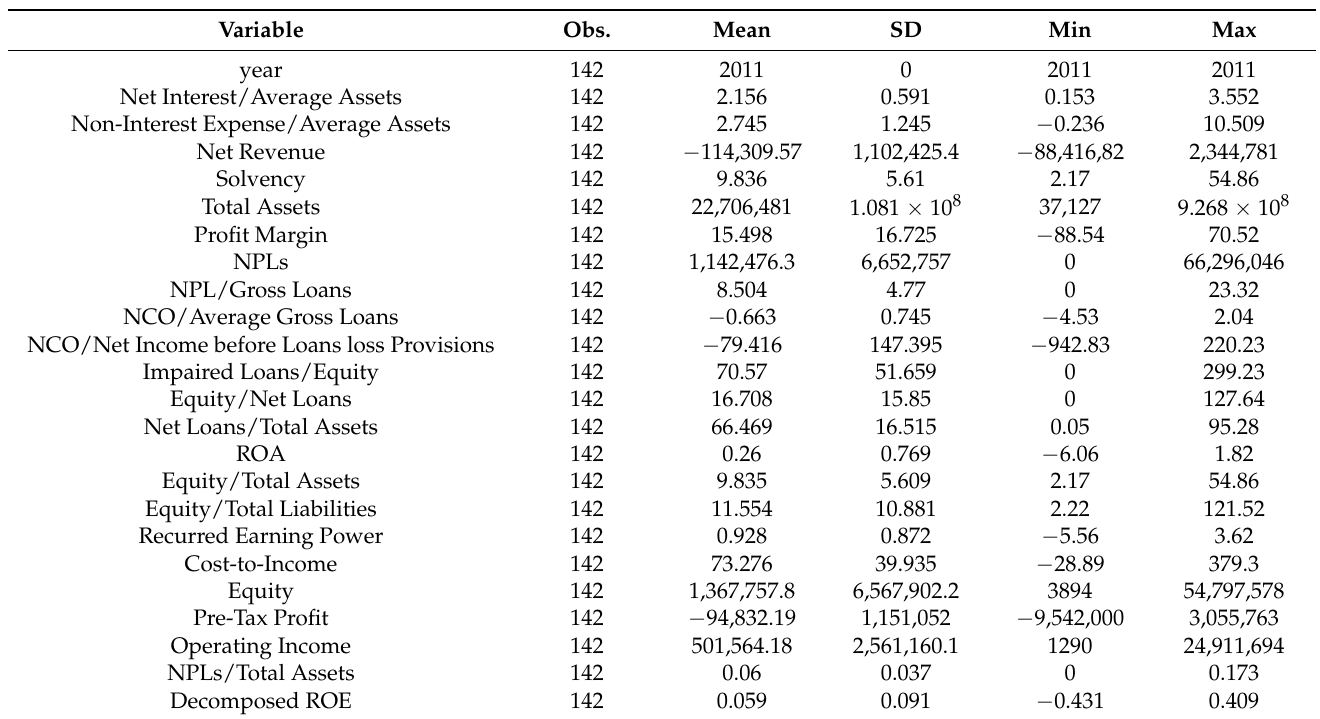
Table A1. Descriptive statistics for the 142 Italian banks for the year 2011.